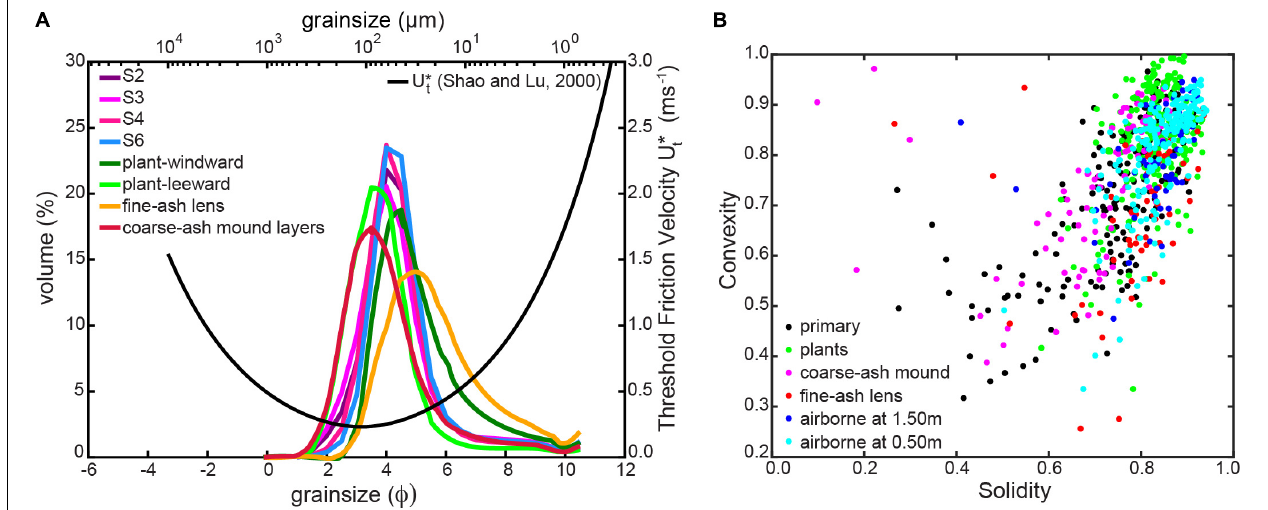
FIGURE 10 | (A) Grainsize distributions of ground (plants, ash lenses and mound layers) and airborne (sites S2, S3, S4, S6) samples and the theoretical threshold friction velocity U ∗ t (Shao and Lu, 2000). (B) Solidity and convexity values for the different types of remobilised samples for size class 2 (63–125 µ m), which is the class with the largest variation in both